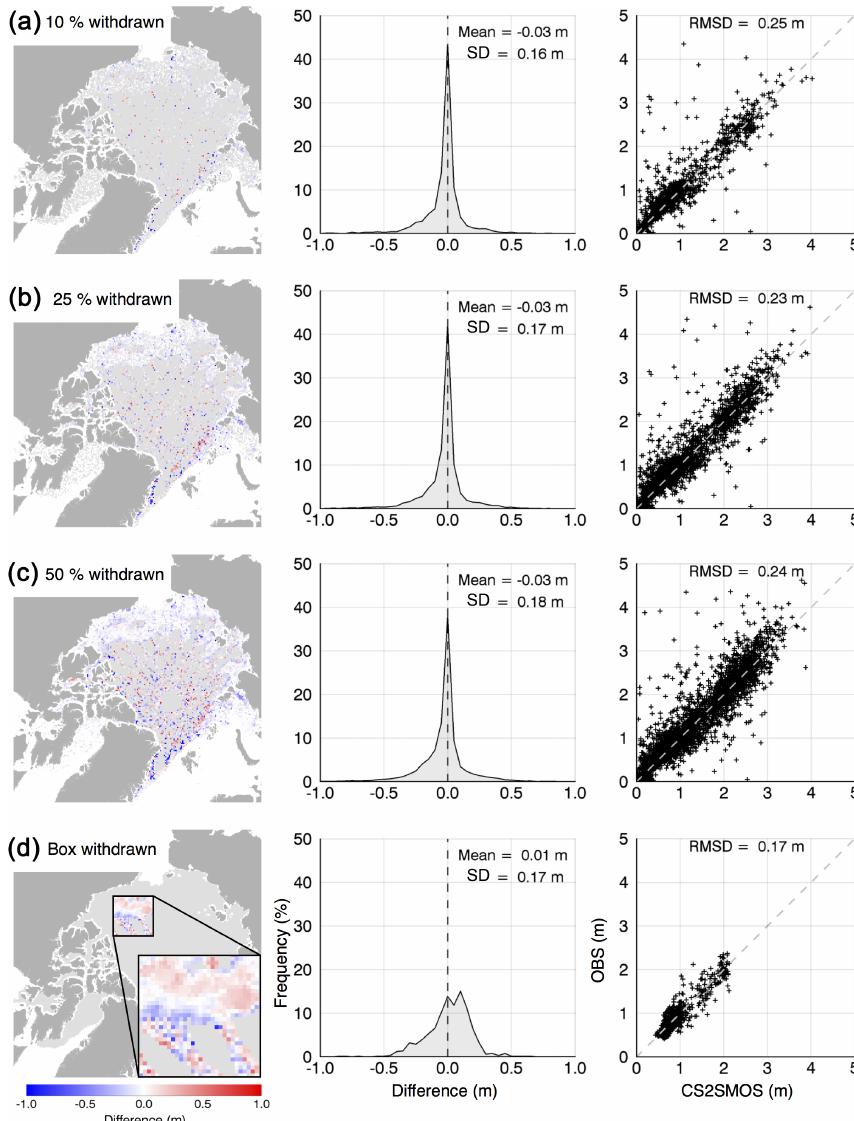
Figure 12. Cross-validation experiment for November 2015, showing the difference between CS2SMOS ice thickness, gridded CryoSat- 2 and SMOS observations (OBS) that have been separated in advance as different fractions/areas of withdrawn data: (a) 10%, (b) 25%, (c) 50% and (d) box. The maps show the withdrawn data subtracted from the CS2SMOS product. The histograms show the differences according to the maps, indicating the mean and standard deviation (SD) of the differences. Scatter diagrams indicate the root mean square deviation